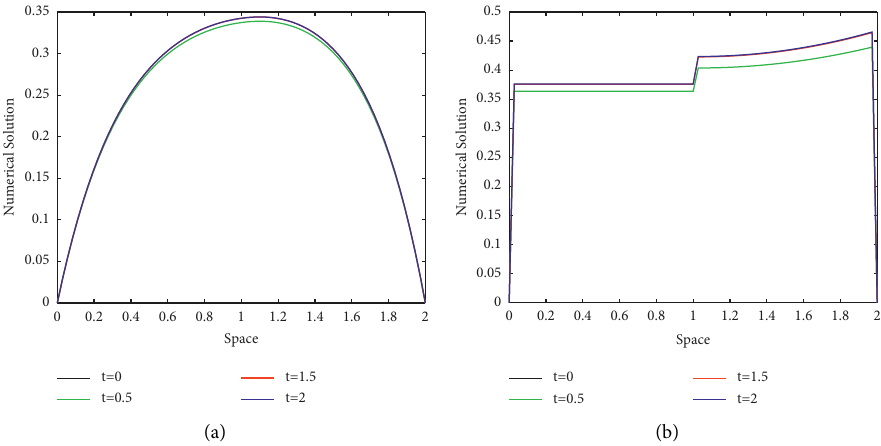
Figure 3: Line plots for the numerical solution of Example 2 for N � 128 and M � 64 at diferent time levels. (a) [ ε � 2 0 ], (b) [ ε � 2 − 14 ].